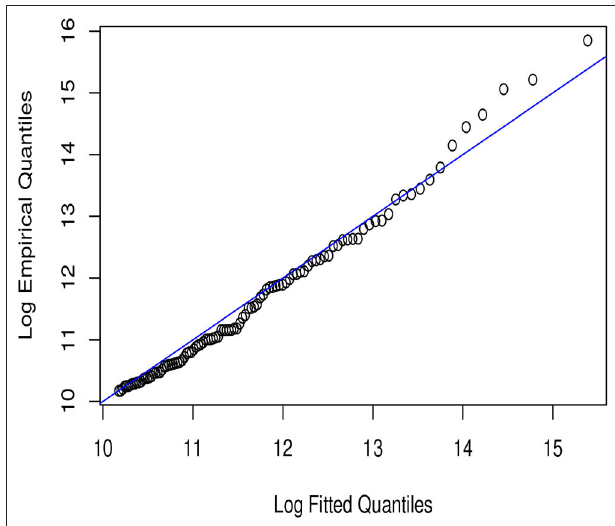
FIGURE 6 | Weibull QQ-plot.